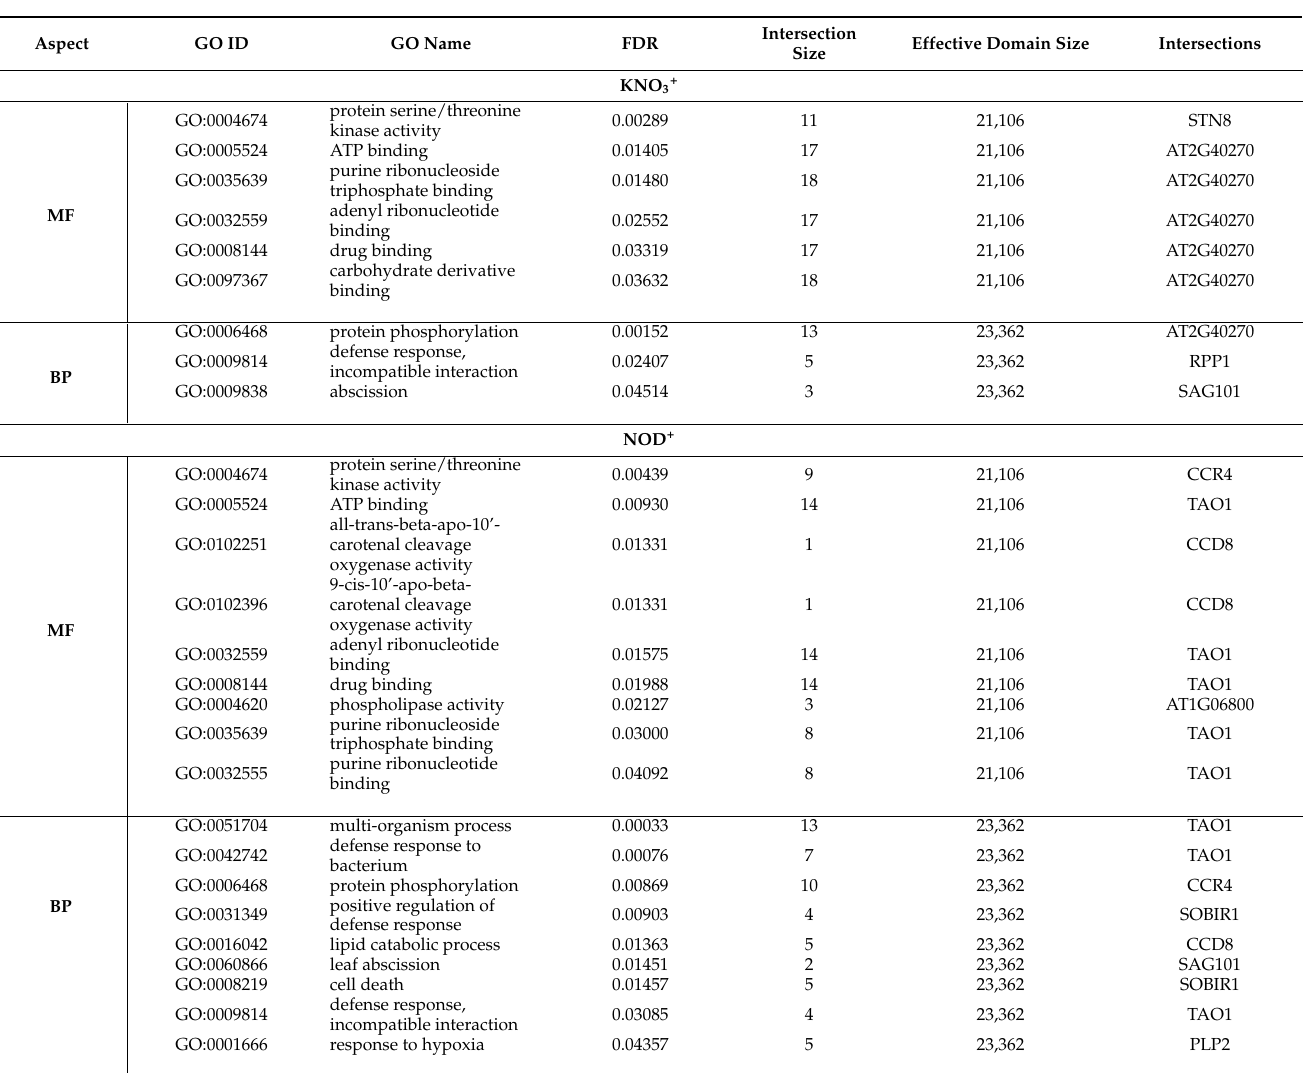
Table 7. Significantly enriched Gene Ontology (GO) terms, identified by Gene Set Enrichment Analysis (GSEA) of downregulated differentially expressed genes (DEGs) in non-nodulated Casuarina glauca plants supplied with KNO 3 (KNO 3+ ) or nodulated by nitrogen-fixing Frankia casuarinae Thr (NOD + ), grown at 600 mM NaCl, relative to control (0 mM NaCl). GO aspect, GO ID, GO Name, False Discovery Rate (FDR), intersection size, effective domain size and main gene intersections were retrieved from g:GOSt functional profiling of the gProfiler website, within a threshold of FDR < 0.05. GO Names coloured in blue were found to be enriched for DEGs at 600 mM NaCl in both plant